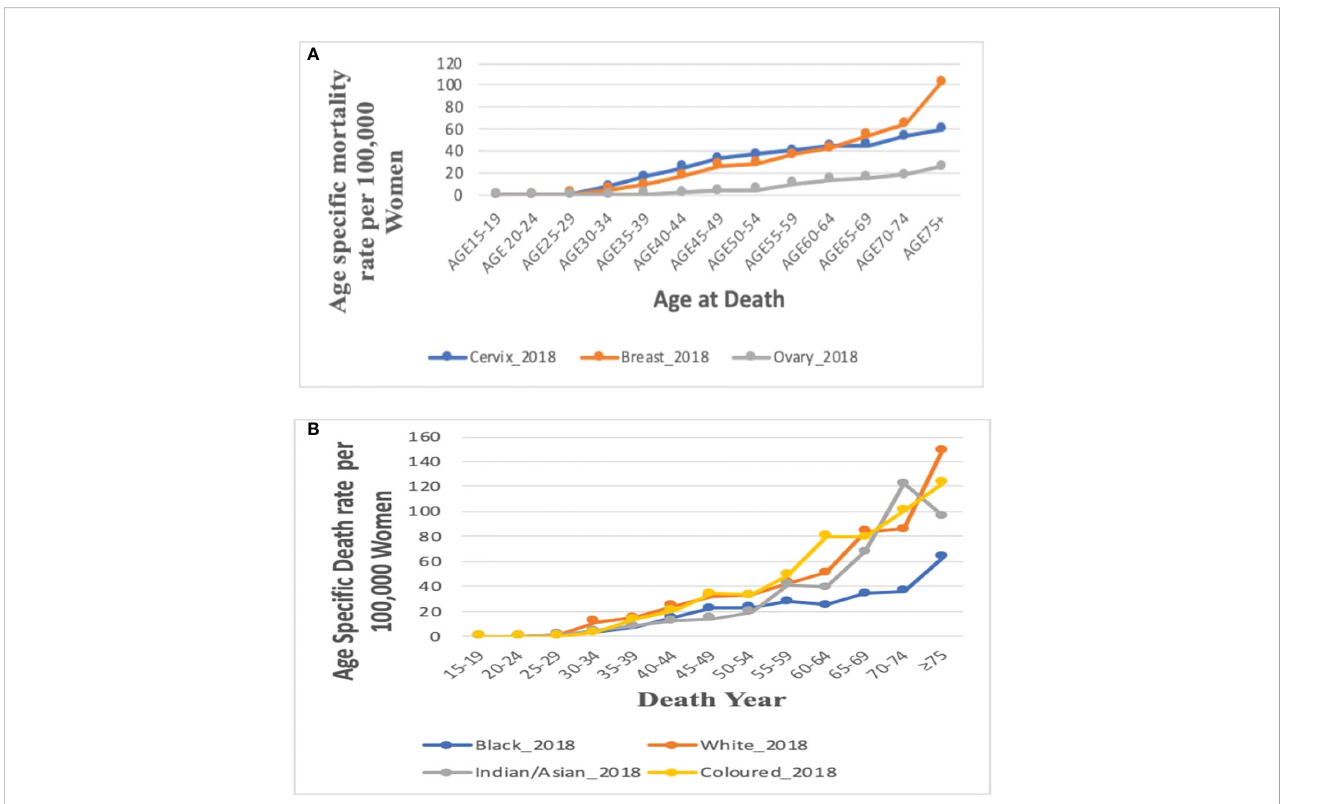
FIGURE 5 (A) Comparison of the overall age-speci fi c death rates in 2018 in South Africa from breast, cervix, and ovaries. Figure 5 (B) . Age-speci fi c death rate by ethnicity for breast cancer in